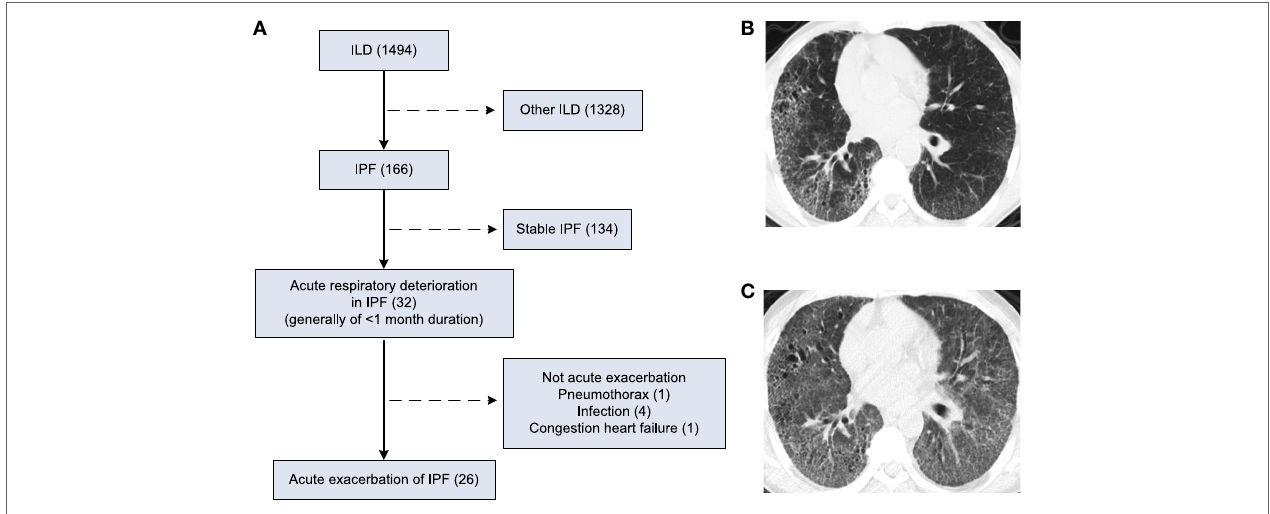
FigUre 1 | Patient flow chart and chest X-ray and high-resolution computed tomography (HRCT) images of patients. (a) Patient flow chart. (B) HRCT image of a patient with IPF. (c) HRCT image of the patient in D who developed